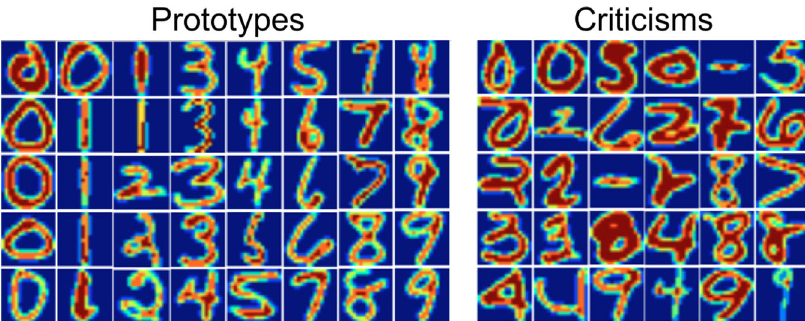
Fig. 6 Example of prototype and criticism explanations. Kim et al. 62 found random subsets of prototypes and criticisms of the USPS handwritten digits data set 157 by applying the MMD-critic technique 62 . Prototypes and criticisms are interesting because prototypes can bene fi t data understanding while criticisms can bene fi t data cleaning. Figure reprinted from ref. 62 with